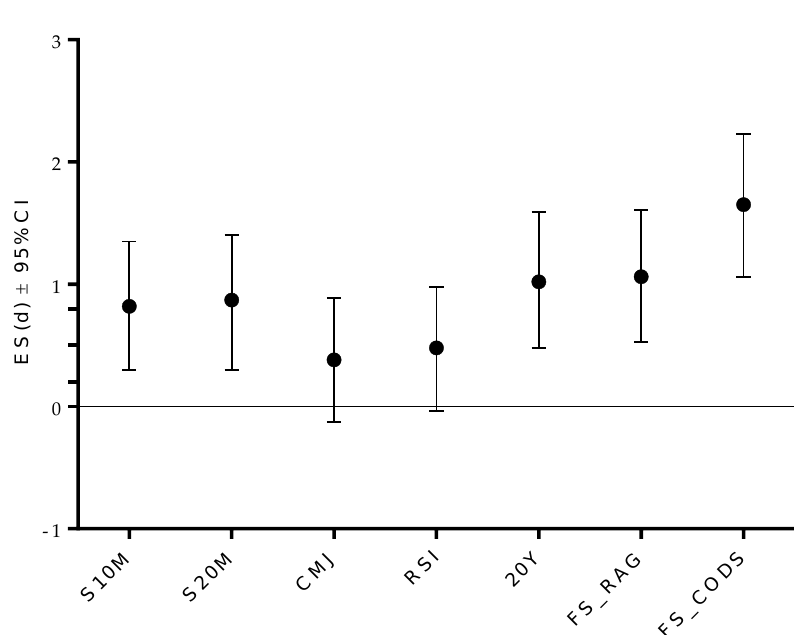
Figure 2. E ff ect size (ES) di ff erences in studied variables between U13 and U15 age-category. LEGEND: Figure 2. Effect size (ES) differences in studied variables between U13 and U15 age-category.